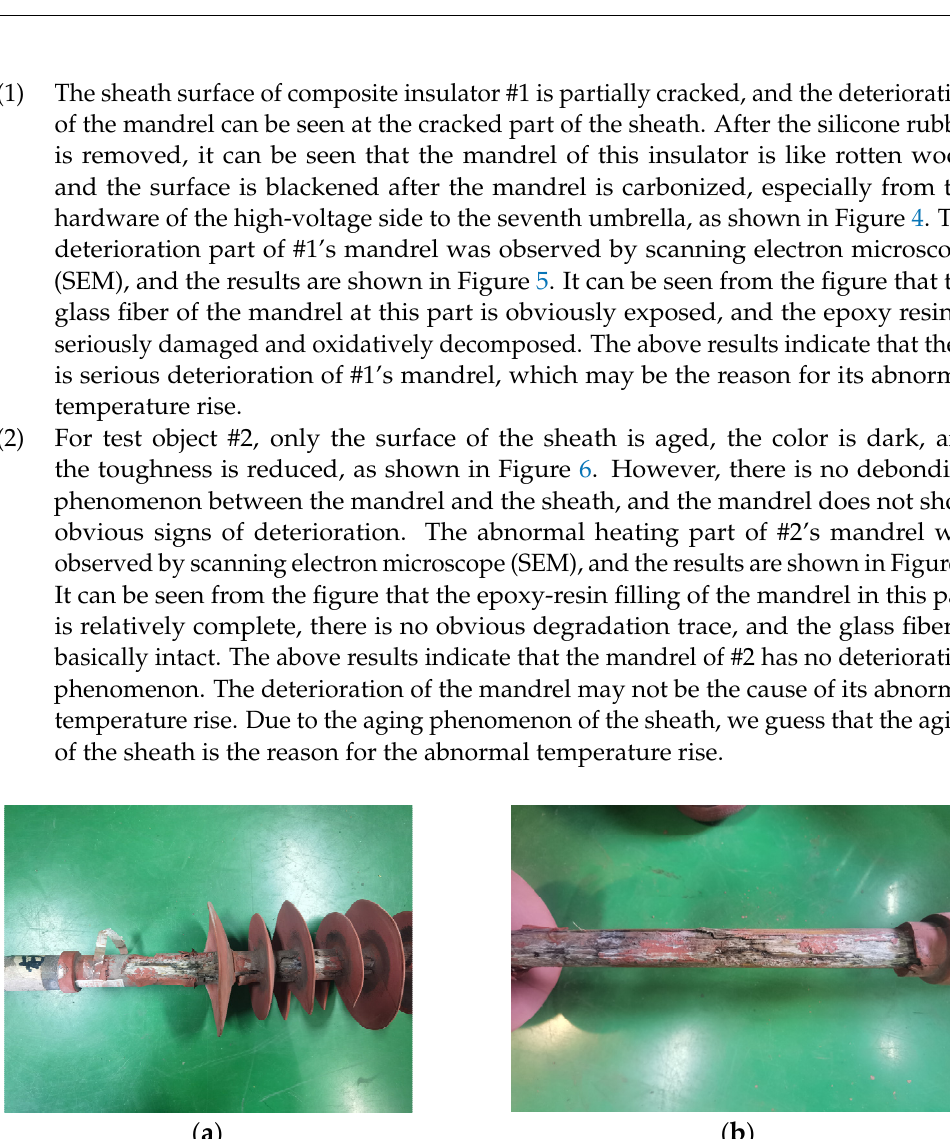
Figure 3. ( a ) Test object #1’s infrared image; ( b ) test object #2’s infrared image.